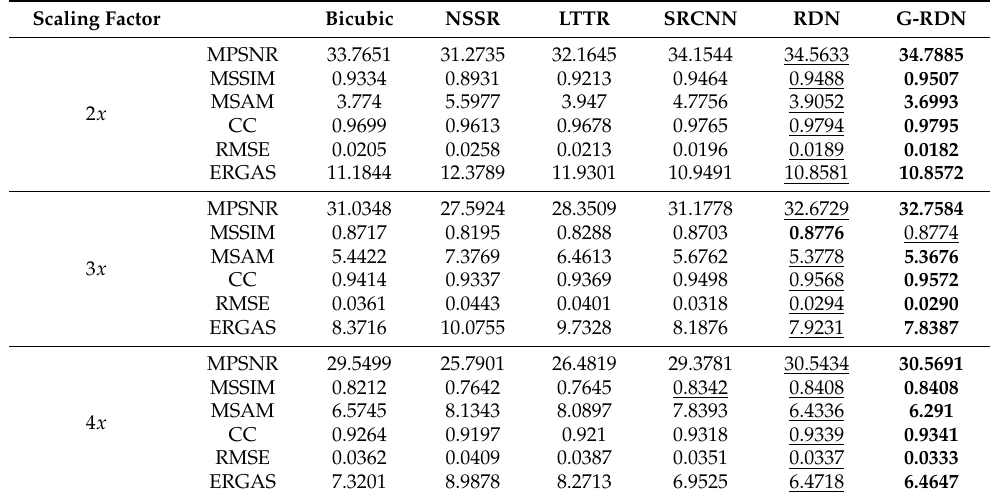
Table 3. Average measurement metrics for the Washington DC Mall dataset. Scaling Factor